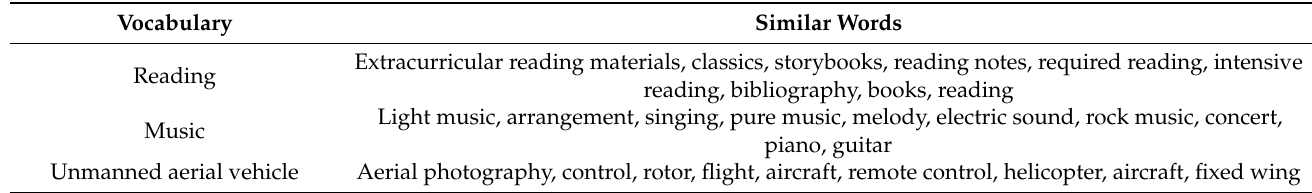
Table 1. Similar words based on word